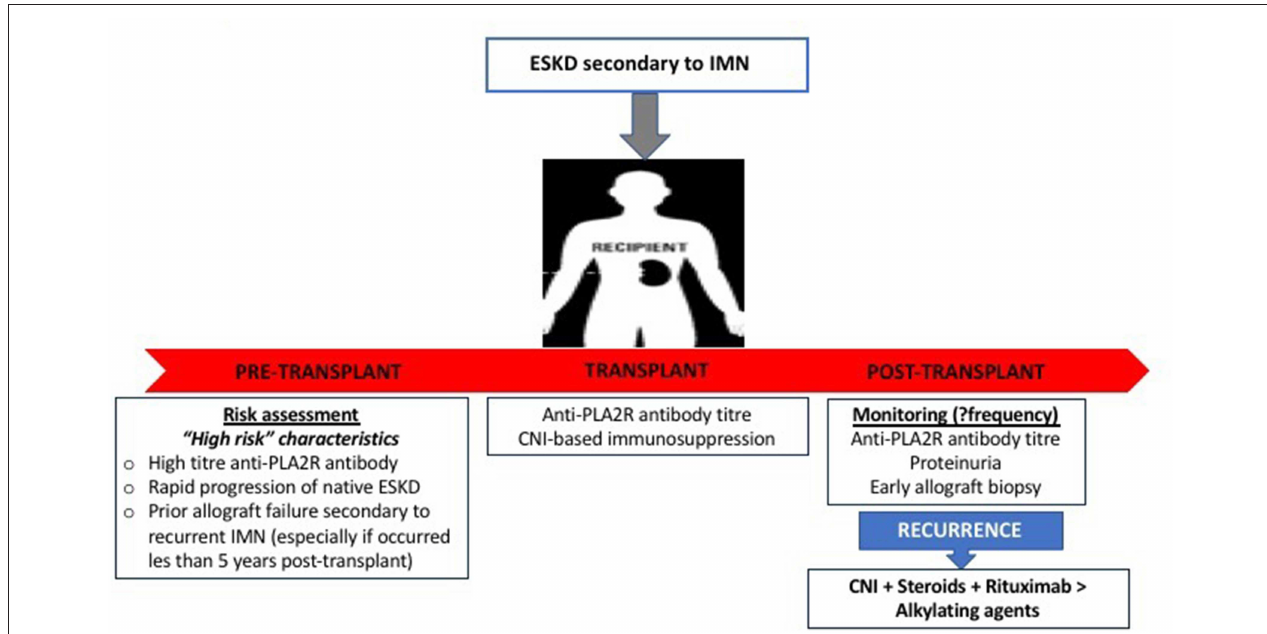
FIGURE 4 | Practical approach to the pre- and post-kidney transplant risk assessment and management of patients with end-stage kidney disease secondary to idiopathic membranous glomerulonephritis.